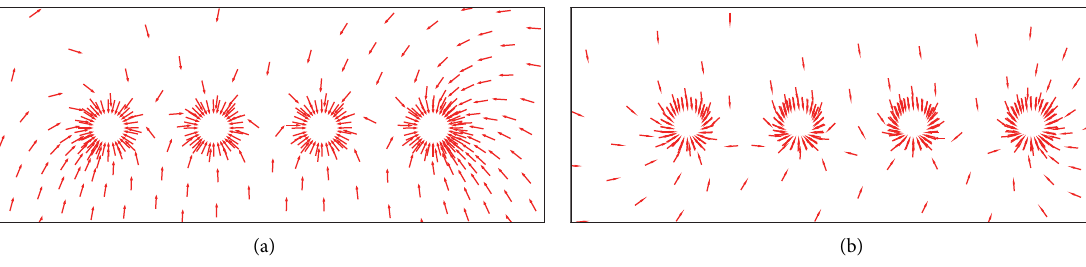
Figure 14: The flow vector figures with different support patterns. (a) Without lining after excavation. (b) With lining after